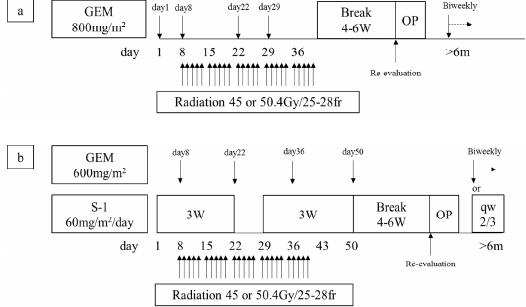
Figure 1. The CRTS protocol at Mie University Hospital. ( a ) GEM-CRT (2005.2–2011.10, enrolled patients: n = 128, re-evaluated patients: n = 116); ( b ) S-1/GEM-CRT (2011.11–2016.12, enrolled patients: n = 179, re-evaluated patients: n = 169). GEM: gemcitabine, W: week, OP: operation, m: months, qw: